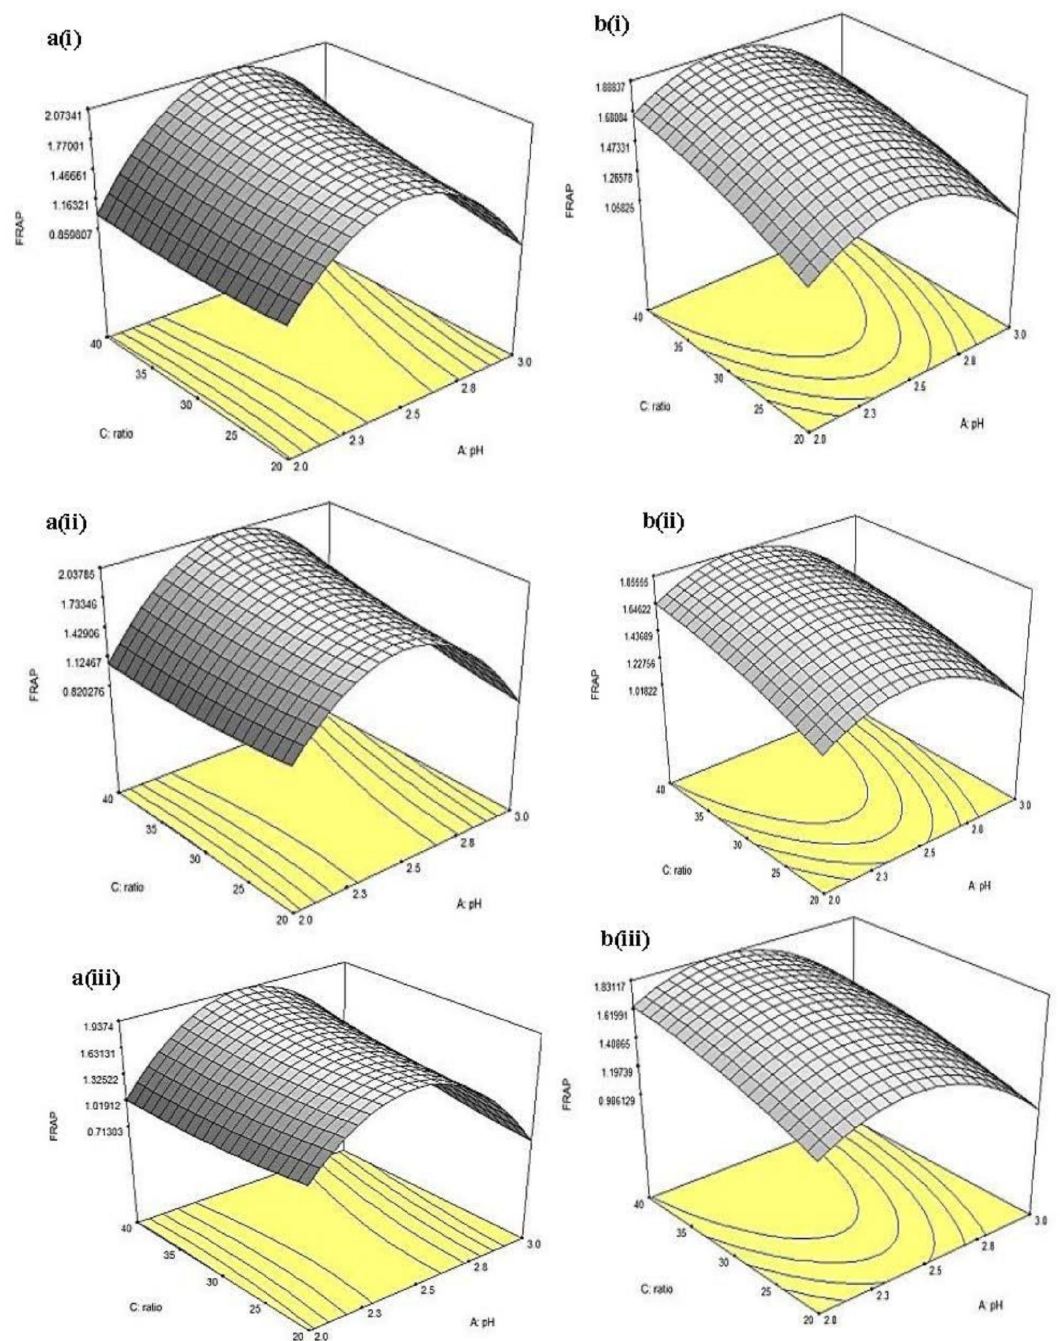
Figure 10. Three-dimensional response surfaces for FRAP of ( a ) China cultivar of lotus root at (i) 0.5, (ii) 1, (iii) 1.5 h extraction time and ( b ) Malaysia cultivar of lotus root at (i) 0.5, (ii) 1, and (iii) 1.5 h extraction time as a function of pH and solvent-to-sample